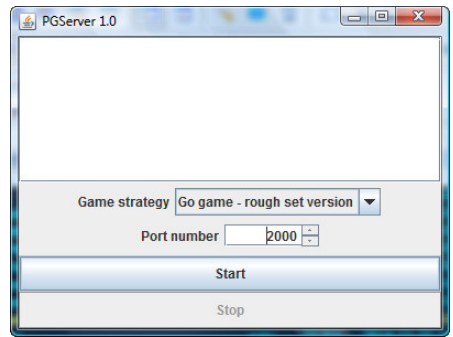
Figure 8: The main window of PGServer